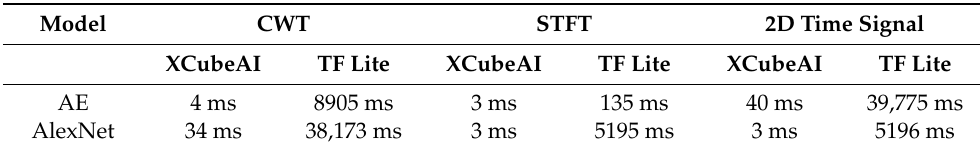
Table 7. Comparison of Inference time for CWT, STFT and 2D time signal features for AlexNet and AE on Nucleo